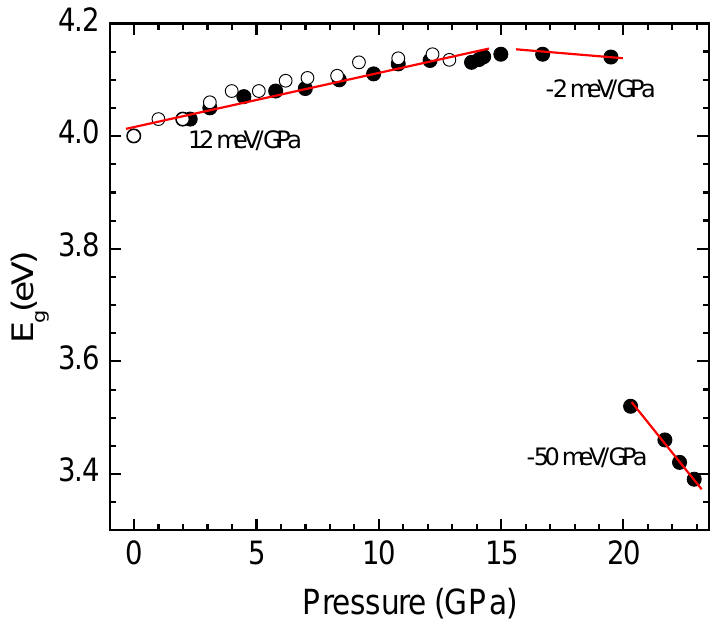
Figure 8. Pressure dependence of the band-gap energy for the low- and high-pressure phases of CdWO 4 .